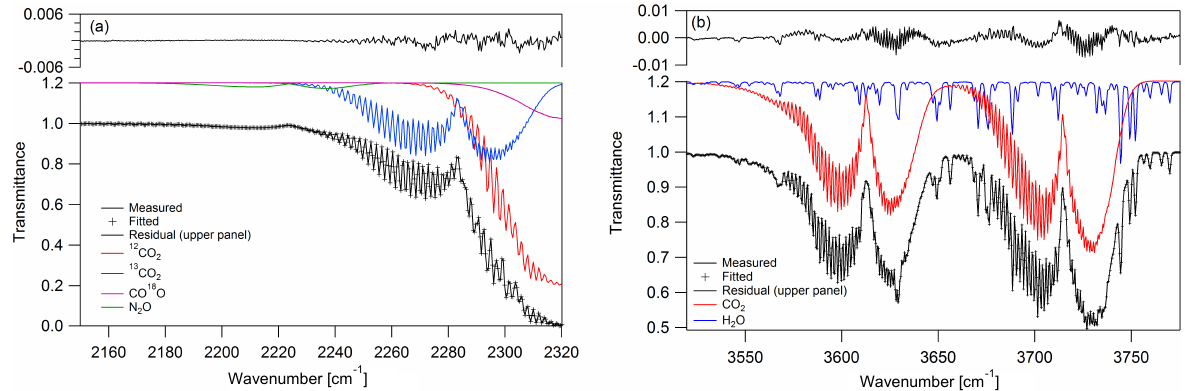
Figure 1. (a) Spectra of CO 2 isotopologues and N 2 O in the 2150–2320cm − 1 region. The coloured traces show the individual isotopologues, the black spectra are a measured air spectrum (black line), calculated best-fit spectrum ( + symbols) and the fitting residual (black, upper panel). (b) Spectrum including CO 2 and H 2 O near 3600cm − 1 . The individual trace gas and isotopologue spectra are shifted by 0.2 upwards for